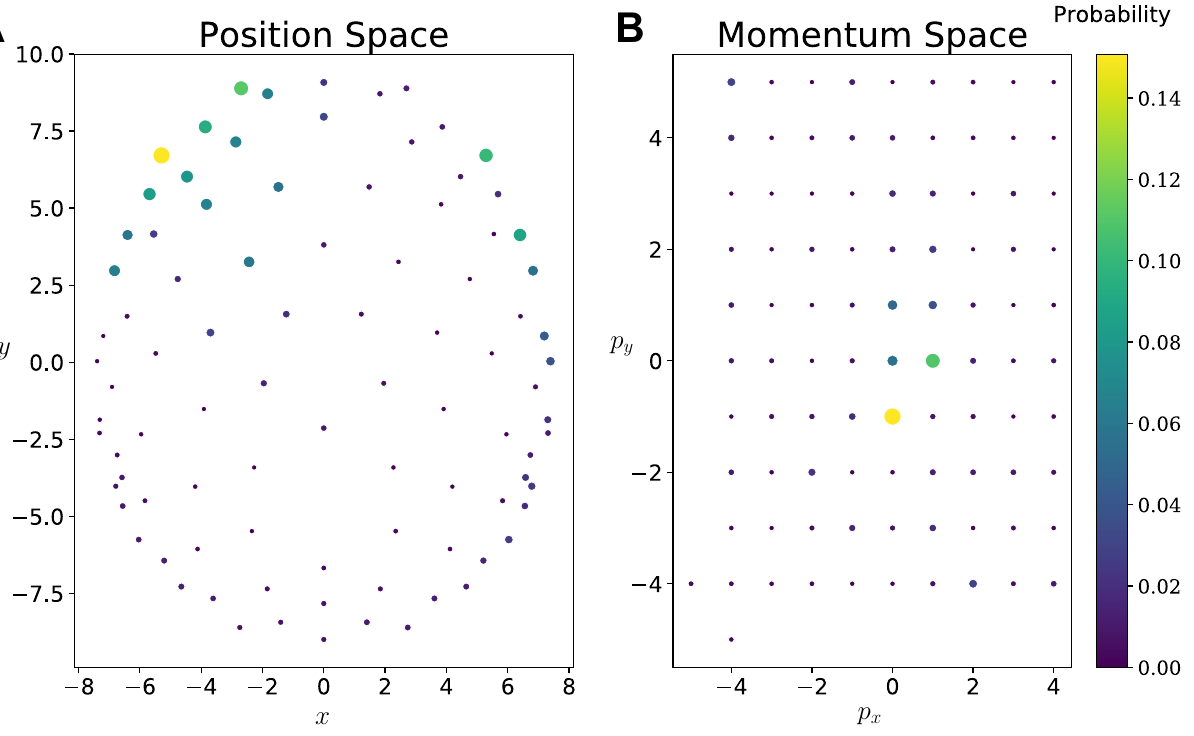
Figure 4. ( A ) Probability distribution for a single subject in the position basis. ( B ) Momentum basis probability distribution for a single subject. The momentum values used for the Fourier transform are indicated by the point locations. Points are colour-/size-coded to represent the probability value at that